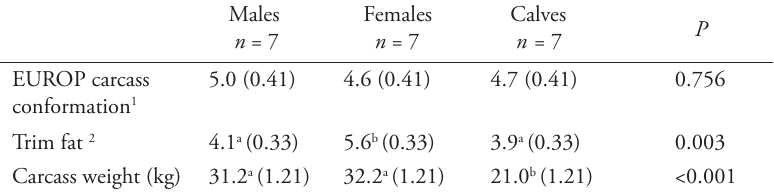
Table 2a. Carcass conformation, trim fat content and dressed carcass weight of free rang- ing reindeer of different age and sex (least-square means and standard